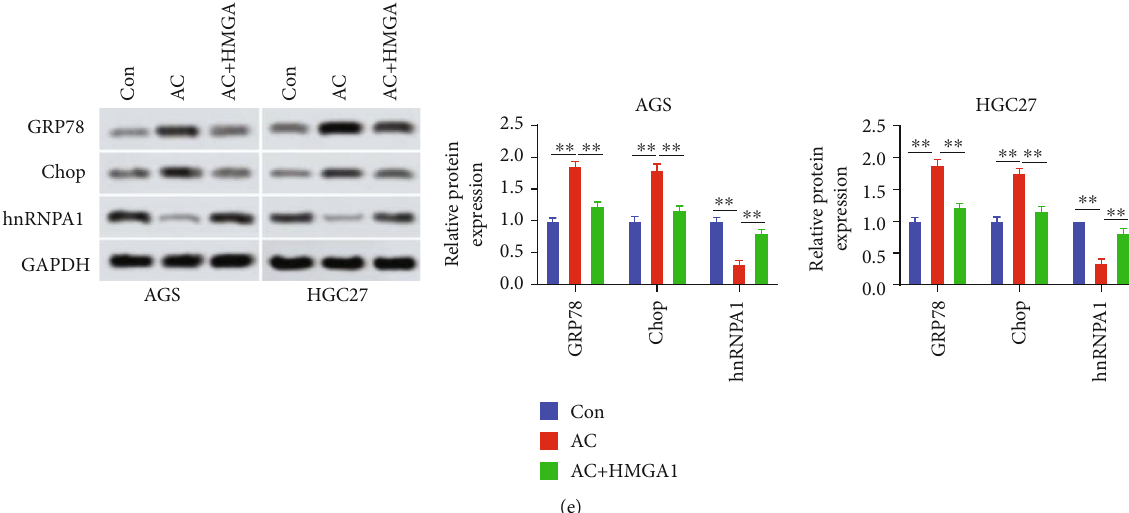
Figure 4: Asiaticoside suppressed gastric cancer cell aggressive behaviors and induced endoplasmic reticulum stress by regulating HMGA1. (a) HMGA1 expression was tested using Western blot in AGS and HGC27 cells after treatment with AC and transfection with the HMGA1 overexpression plasmid. (b) The cell viability after AC treatment and HMGA1 overexpression was assessed by the CCK-8 assay. (c) The cell migration ability of AGS and HGC27 cells after treatment with AC and transfection with the HMGA1 overexpression plasmid was determined using the Transwell assay. (d) The levels of PCNA, E-cadherin, and N-cadherin in cells after AC treatment and HMGA1 overexpression were assessed using Western blot. (e) The levels of GRP78, Chop, and hnRNPA1 in AGS and HGC27 cells after treatment with AC and transfection with the HMGA1 overexpression plasmid were tested using Western blot. ∗∗ P < 0 : 01